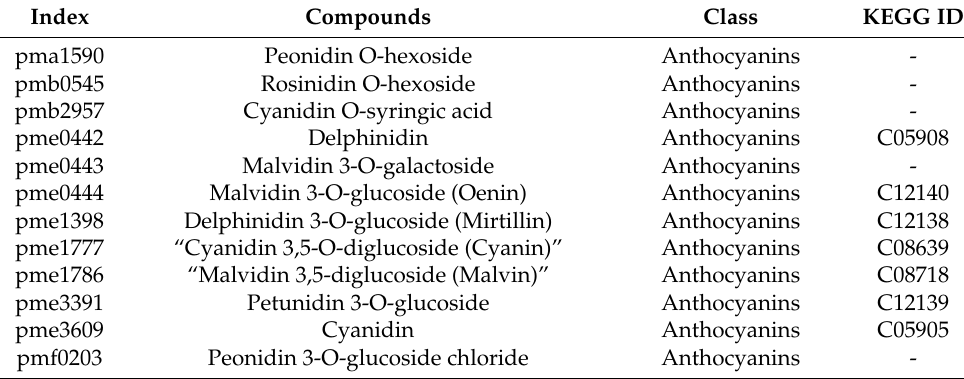
Table 3. Statistical table of metabolite information.